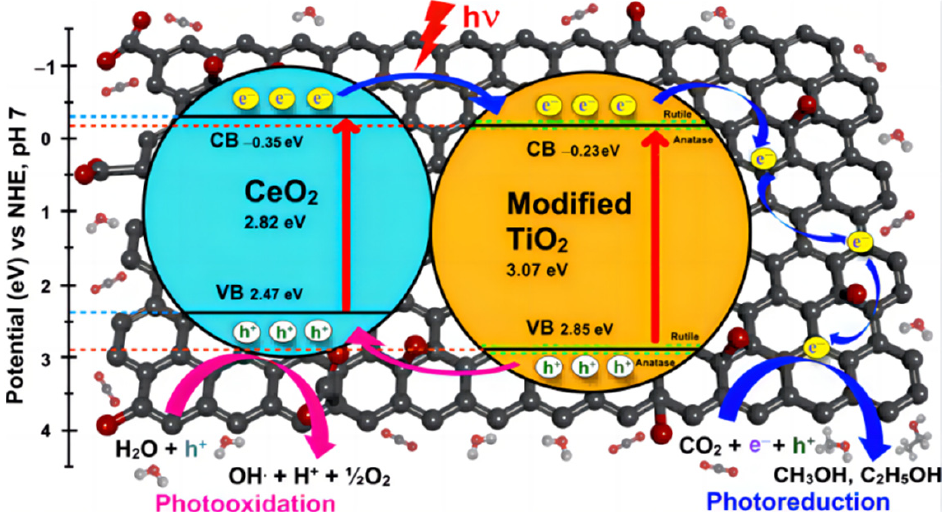
Figure 9. Mechanism for the photocatalytic conversion of CO 2 with H 2 O to methanol and ethanol over TiO 2 /rGO/CeO 2 photocatalysts [53].